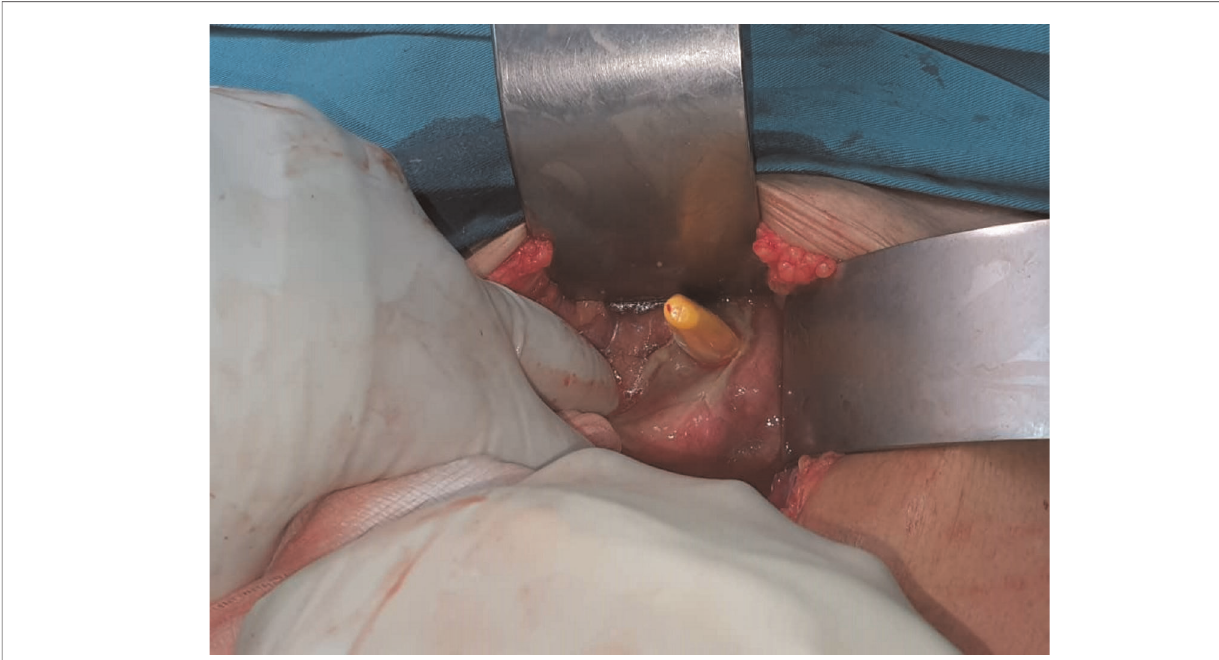
FIGURE 1 | Rectal perforation by the tip of the toothbrush.